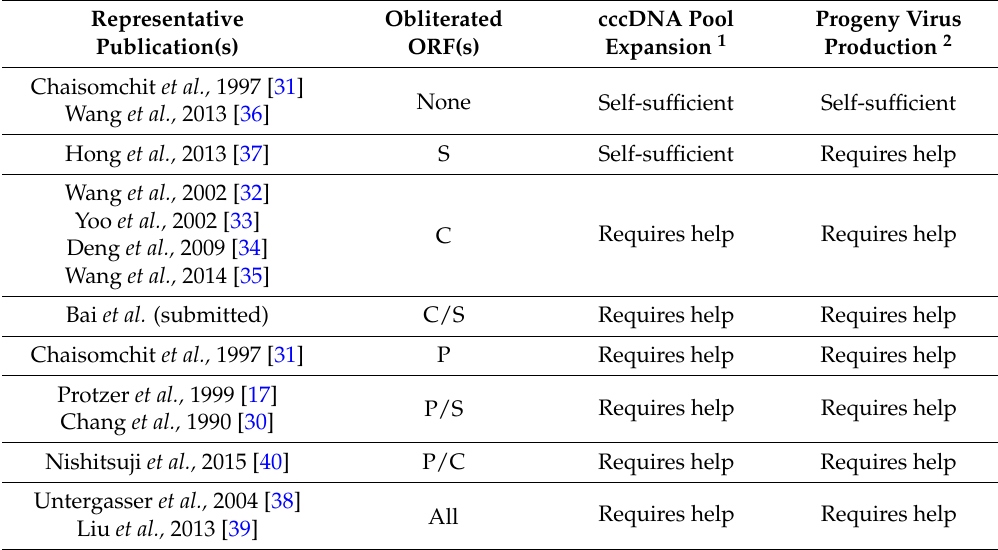
Table 2. Comparison of recombinant hepadnavirus vector